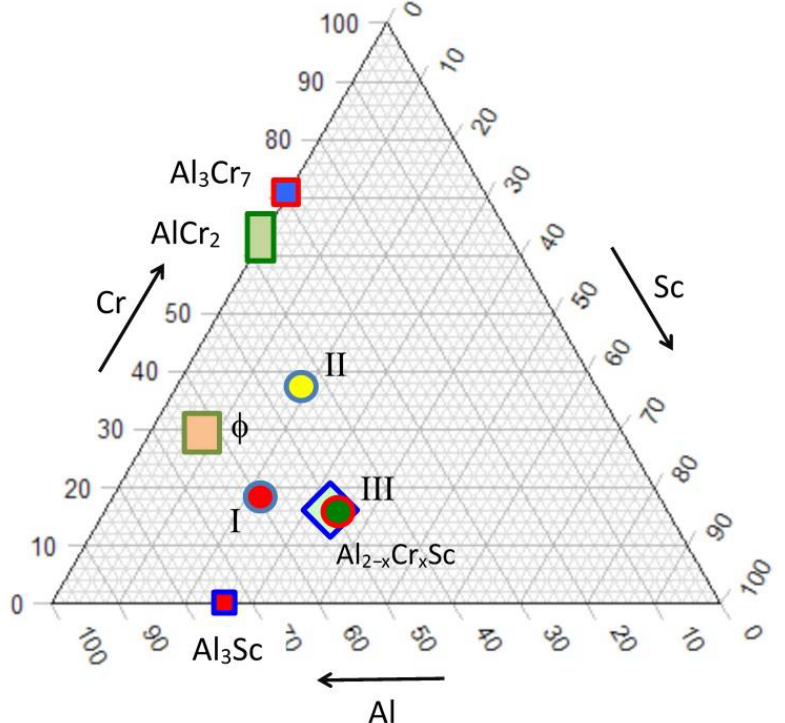
Figure 1. Location of the compositions of the three samples (circles) and crystalline compounds (squares) that were relevant to the present study in a ternary Al-Cr-Sc composition field.